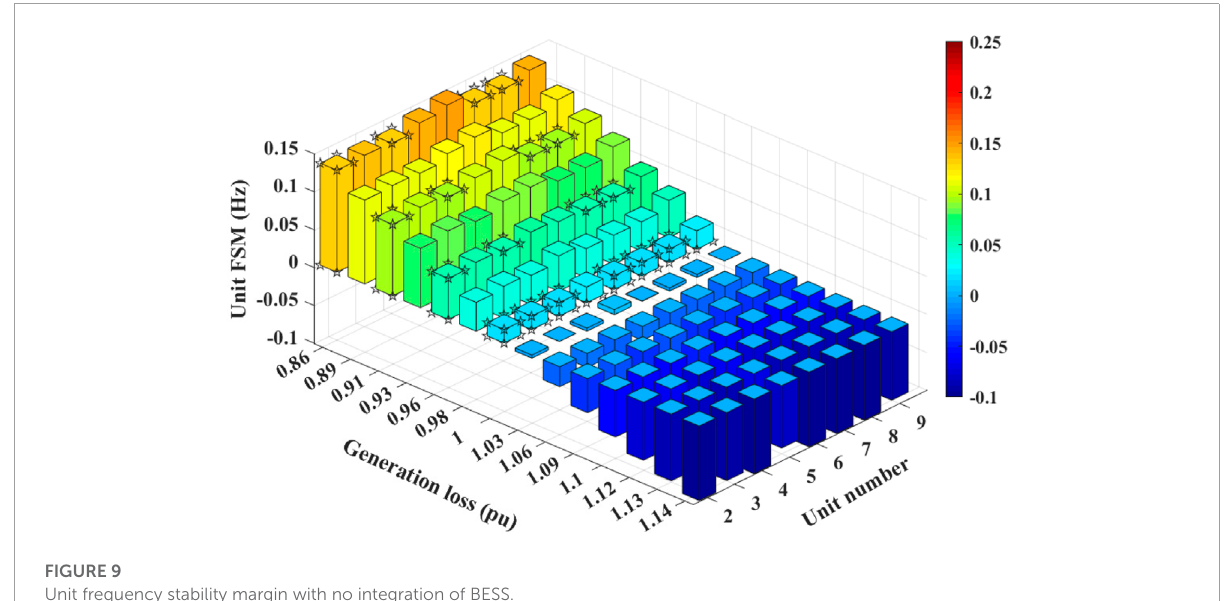
FIGURE 9 Unit frequency stability margin with no integration of BESS.